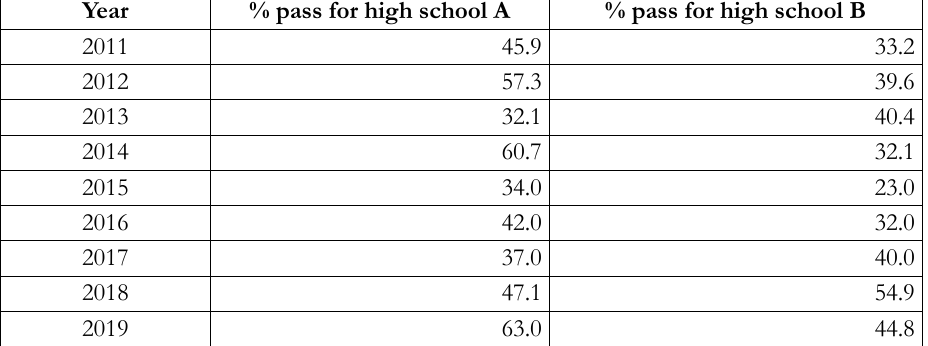
Table 1. Percentage passes in Physical Sciences in two schools in Mankweng Circuit from